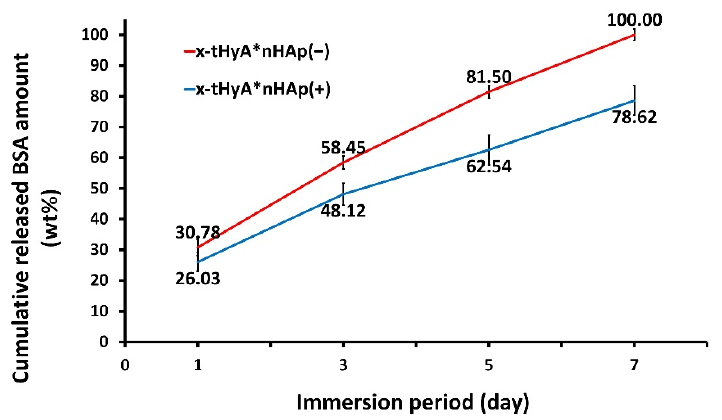
Figure 12. Results of the accelerated protein (BSA) release test of x-tHyA with and without nHAp (x-tHyA*nHAp ( − ) and x-tHyA*nHAp (+)) in saline